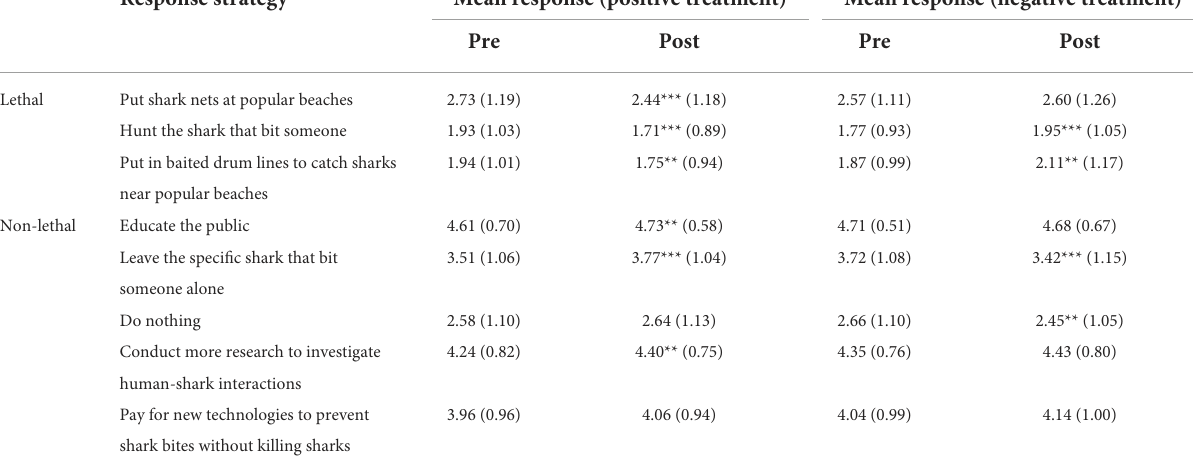
TABLE 5 Individual measures of post shark bite response strategies and associated pre and post treatment mean and standard deviation response values, and paired t -test